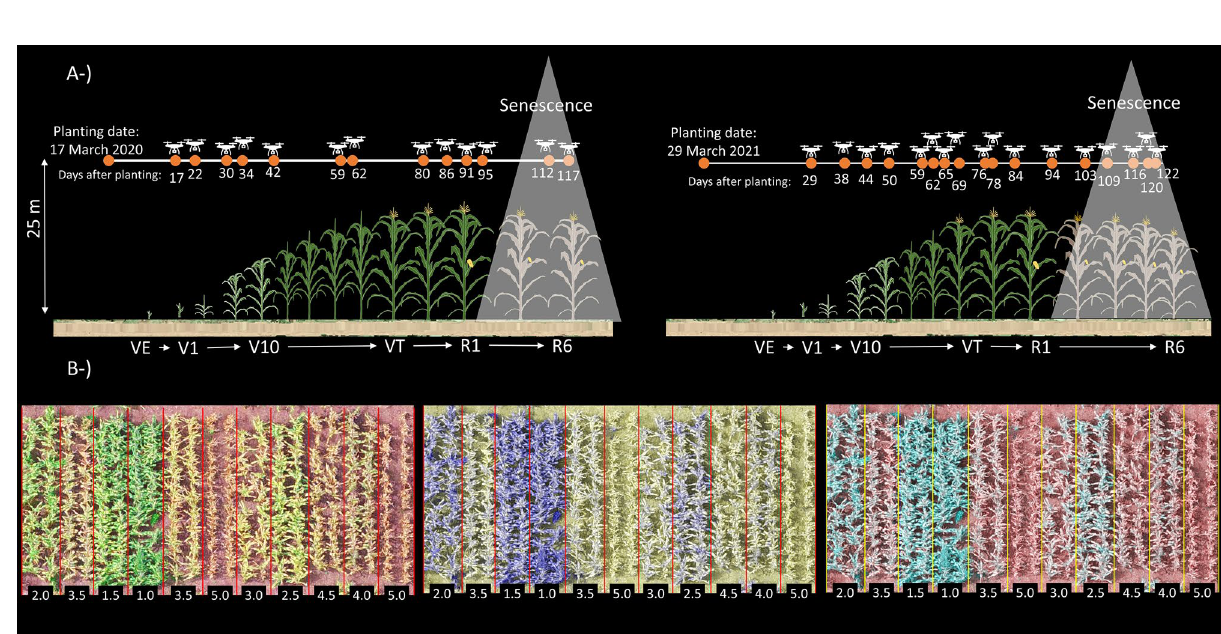
Figure 2. ( A ) The number flight times used in 2020 (left) and in 2021 (right); senescence scored using the orthomosaics of latest four flights in 2021 and two flights in 2020. ( B ) Variation in senescence and illustration of senescence scores on a scale of 0 to 5 (numbers in black boxes) among different maize row plots (each is plot is two rows, outlined by red or yellow rectangles). Three band channels in orthomosaics were set in QGIS as red– green–blue, red–red–green, and red-green-green from left to right respectively and resulted in three different illustrations in highlighting the row plots with different senescence